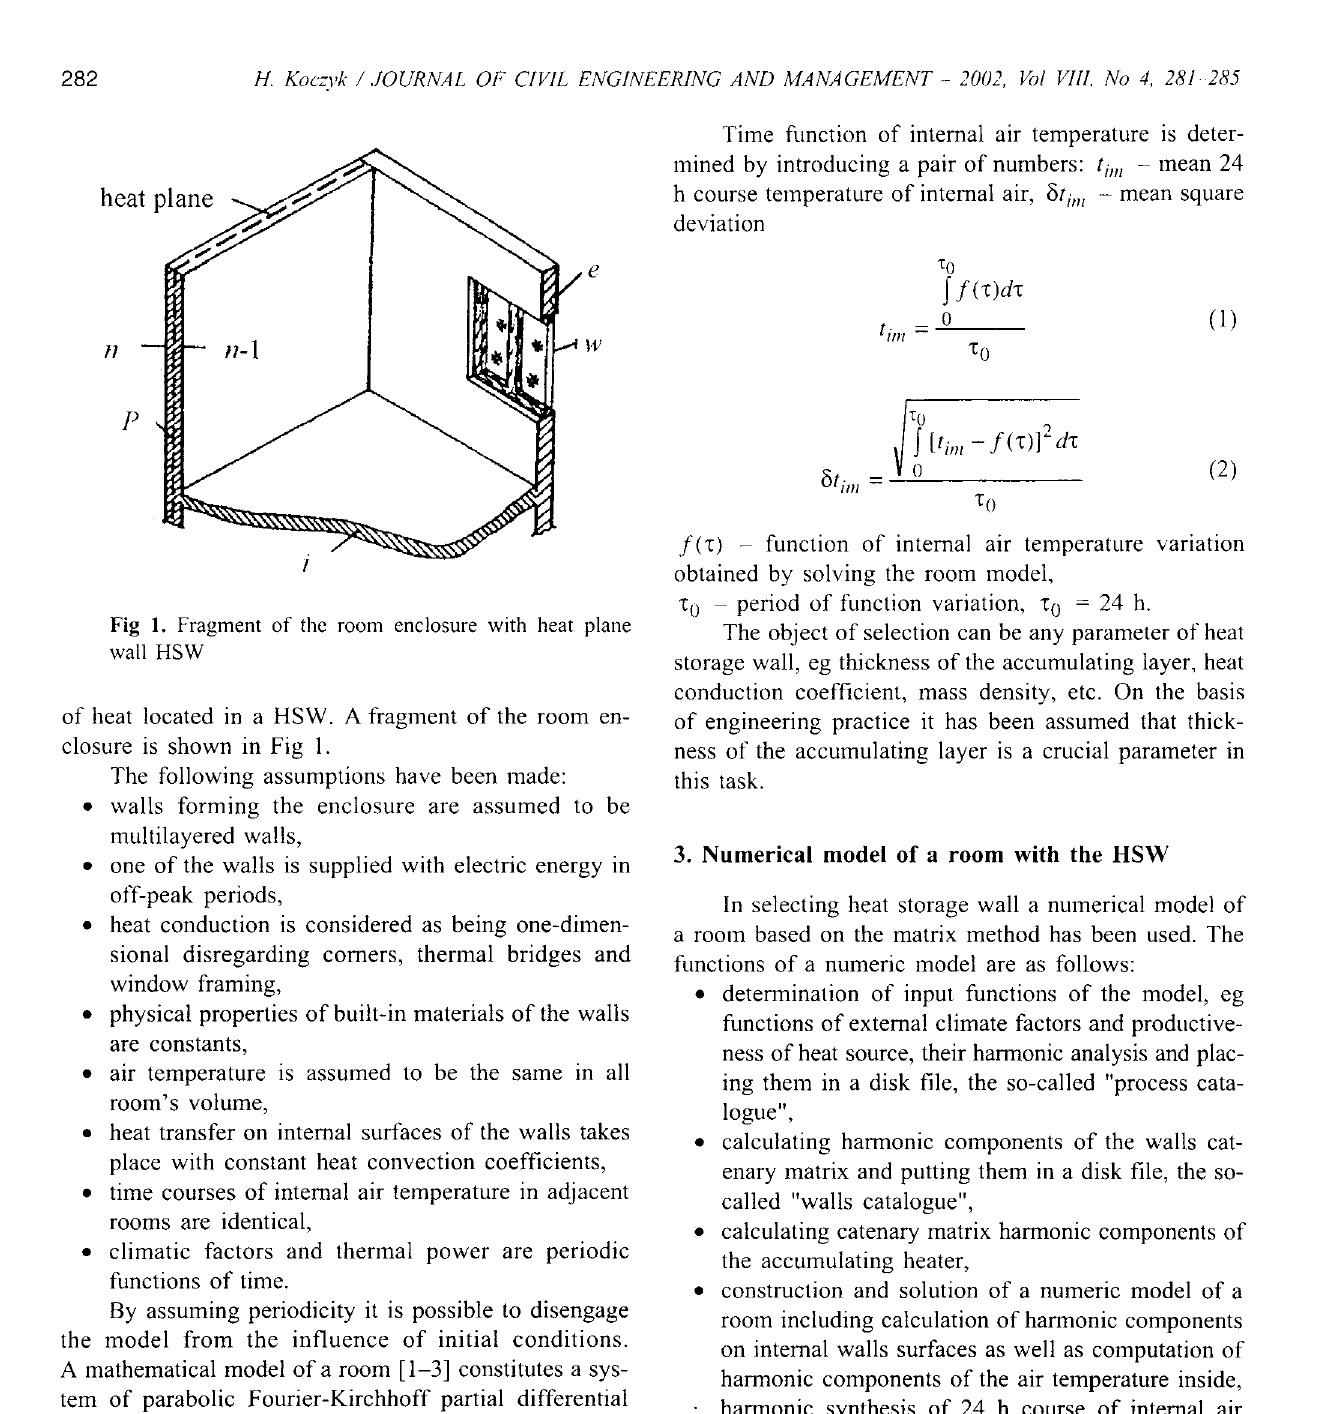
Fig I. Fragment of the room enclosure with heat plane wall